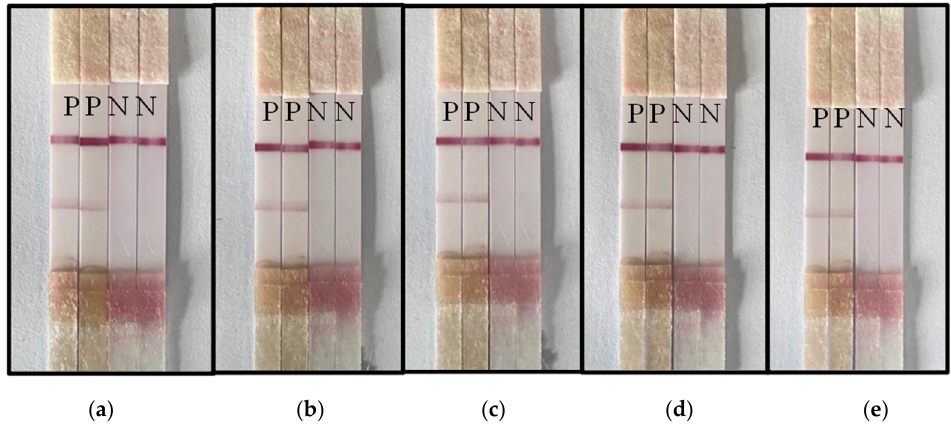
Figure 4. The stability of the test strip for detecting CGMMV. Vacuum storage for ( a ) 14 days, ( b ) 28 days, ( c ) 42 days, ( d ) 56 days and ( e ) 152 days. (P represents CGMMV infected leaves, N represents healthy leaves).